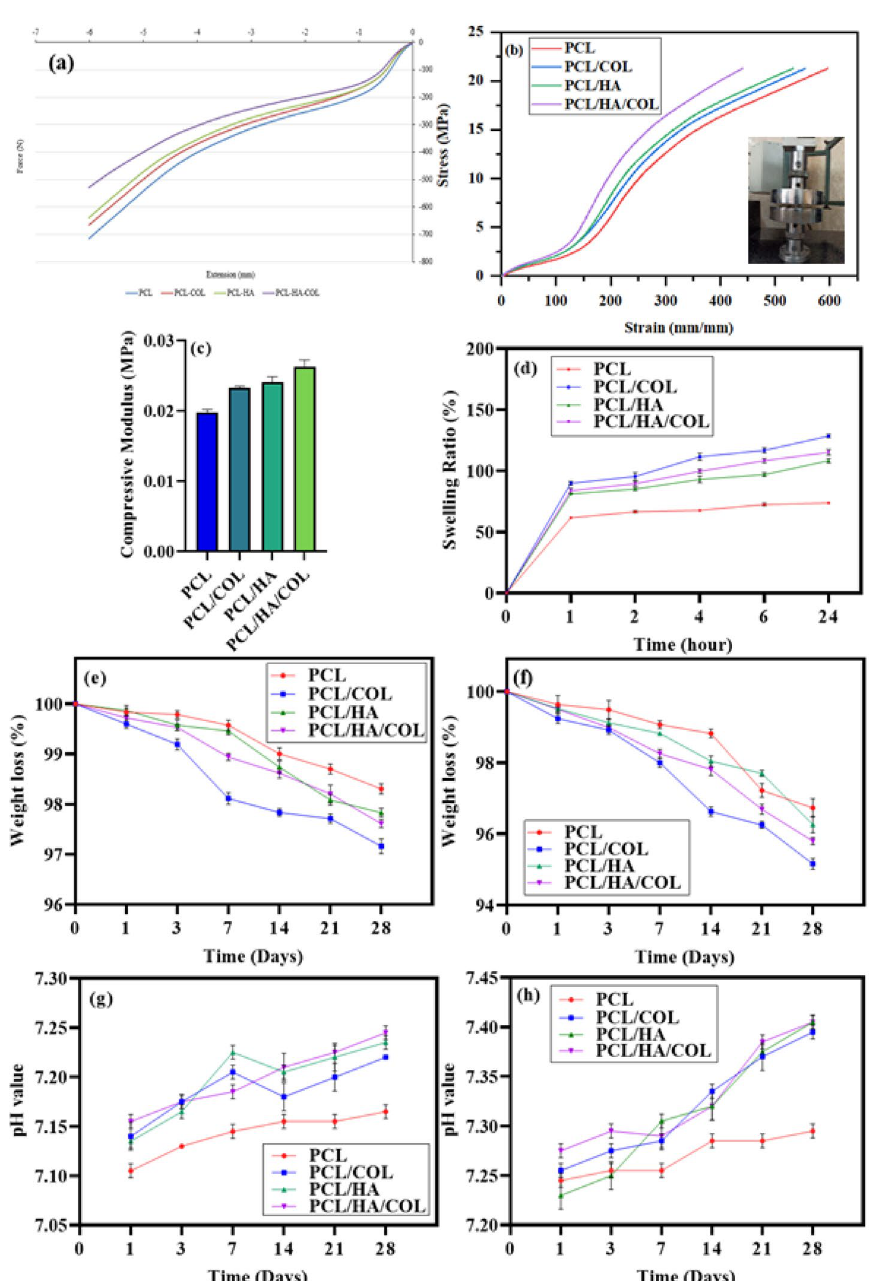
Figure 3. ( a ) Force-extension diagram, ( b ) Stress–strain diagram, and ( c ) compressive modulus for the different scaffolds. ( d ) Variation of swelling behavior of the flat-printed FDM scaffolds. ( e ) Weight loss of PCL, PCL/HA, PCL/COL and PCL/HA/COL scaffold during soaking in PBS and ( f ) PBS-Lipase for 28 days. ( g ) pH values of the scaffolds during the degradation in PBS and ( h ) lipase. Measurements were started after 1 day, day 0 control = pH 7,4. (n = 3 in each group, *p ≤